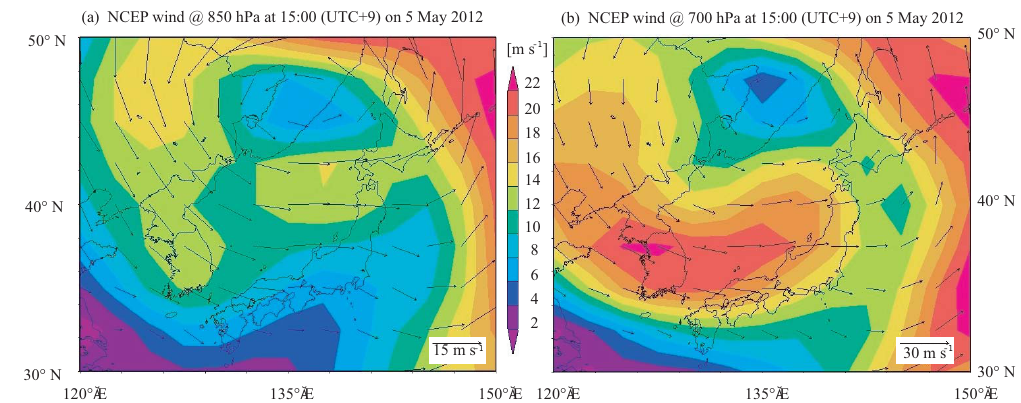
Figure 9. (a) Wind direction and speed at the 850hPa level over Japan at 15:00LT (UTC + 9) on 5 May 2012, by NCEP; (b) wind direction and speed at the 700hPa level over Japan at 15:00LT (UTC + 9) on 5 May 2012, by